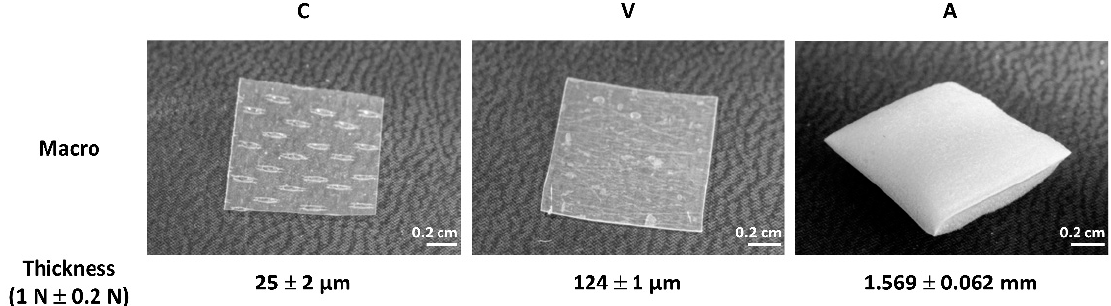
Figure 2. Photographs of collagen sheets and their thickness as analyzed via height gauge. Sample size: 1 × 1 cm 2 . ( C ) Collagen Solutions, ( V ) Viscofan and ( A ) Atelocollagen.